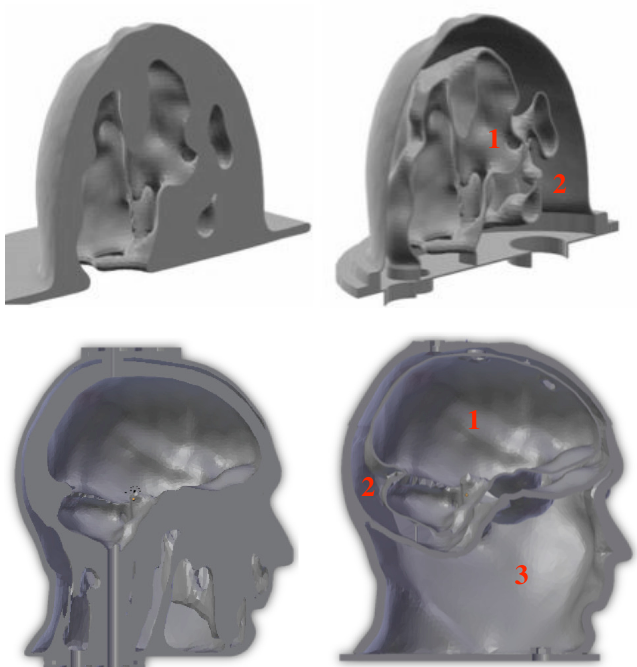
Figure 1. Sagittal sections of the breast ( up ) and head ( down ) phantoms derived from the original STL (stereolithography) files ( left ) and from the modified ones ( right ). The red numbers indicate the various cavities that contain the different TMMs corresponding to: (1) fibroglandular or heterogeneous mix tissues, (2) fatty tissues ( up-right ), and (1) brain, (2) cerebrospinal fluid, (3) miscellaneous tissues ( down-right